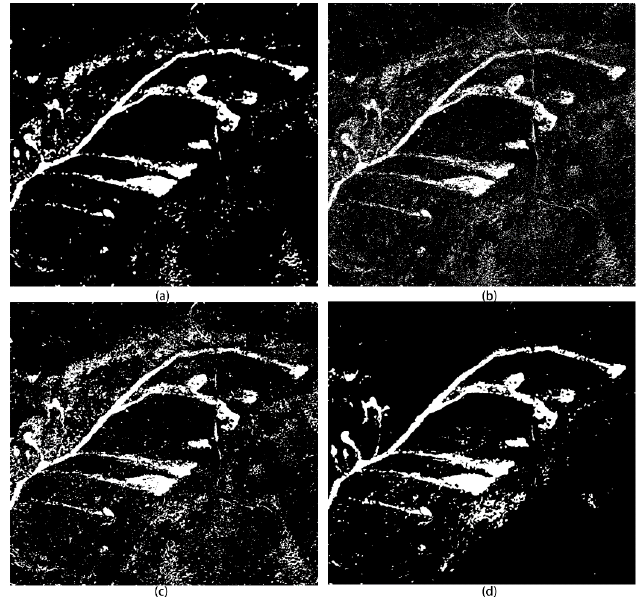
Table 1. Change Detection Quantitative Evaluation (%) on the First Dataset (more details can be tracked in Table S1.).